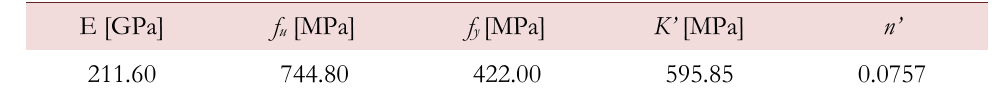
Table 1: Monotonic and cyclic elastoplastic properties of the S355 mid steel.